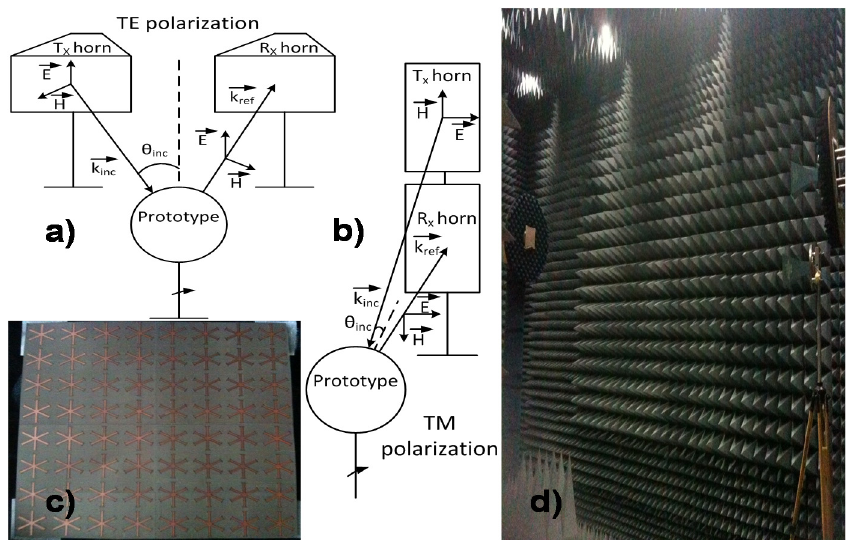
Figure 13. Measurement setup configurations: ( a ) TE; ( b ) TM; ( c ) manufactured prototype; and ( d ) anechoic chamber set up.